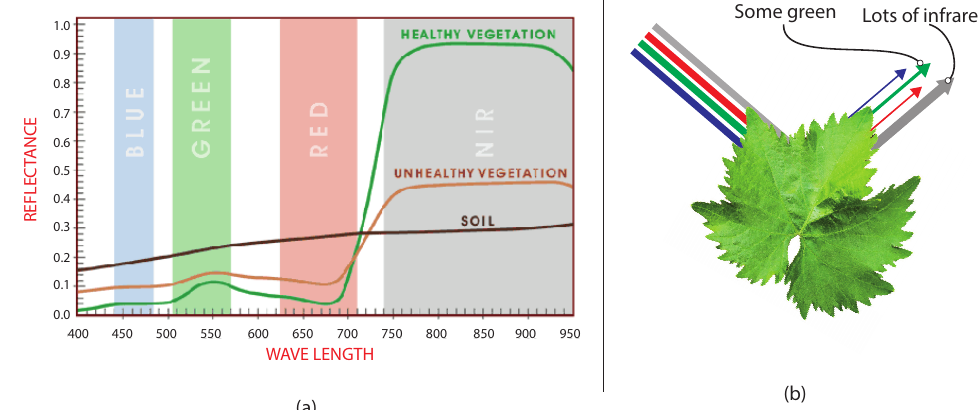
Figure 9. Reflectance spectrum for healthy vegetation, unhealthy vegetation and soil ( a ); vegetation spectral signature ( b